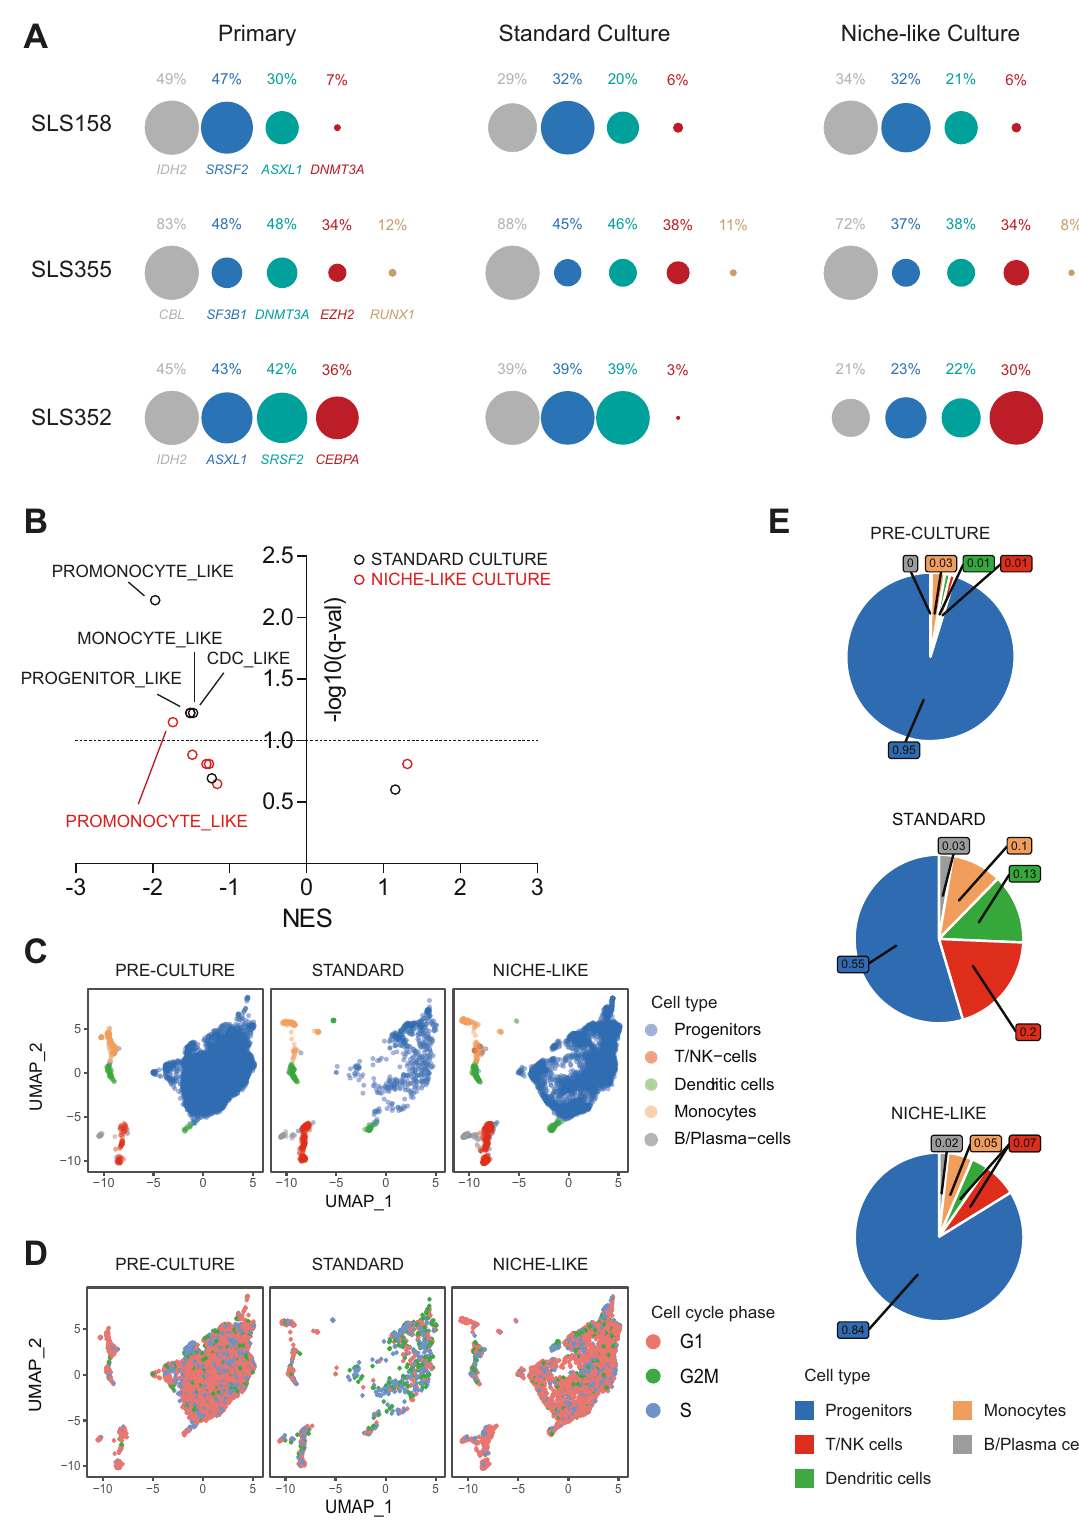
standard culture also signi fi cantly depleted three additional signatures that were preserved in niche-like conditions (FDR < 0.1, Fig. 4b). Finally, single-cell RNA-sequencing revealed that the distribution of BM mononucleated cell populations was preserved after a 72-hour culture in niche-like condition compared to